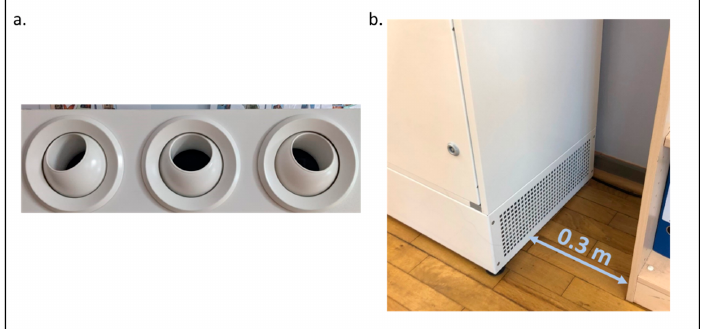
Figure A1. ( a ) Air outlet nozzles of AP 1; ( b ) Side air inlet of AP 2 with the furniture in the Table A2. Characteristics of the AQ Guard from PALAS according to the manufacturer's specifica- tions. Parameters